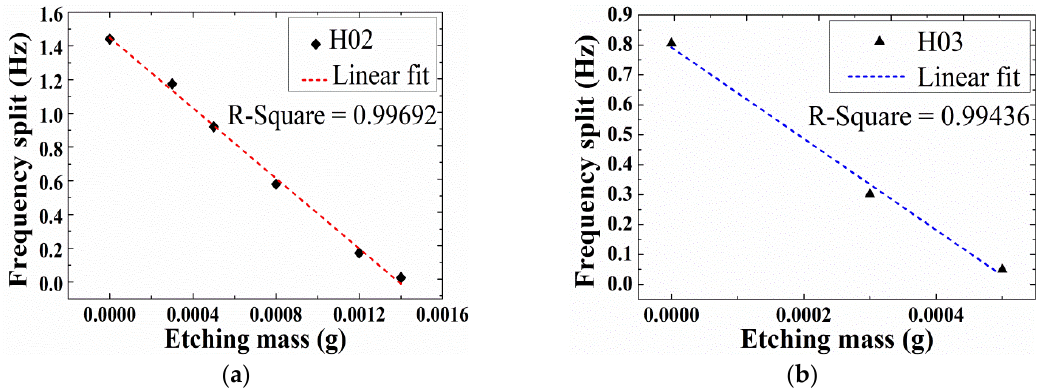
Figure 9. The changes of frequency splits versus etching masses in chemical etching and their linear fits of two hemispherical resonators. ( a ) H02; ( b ) H03.